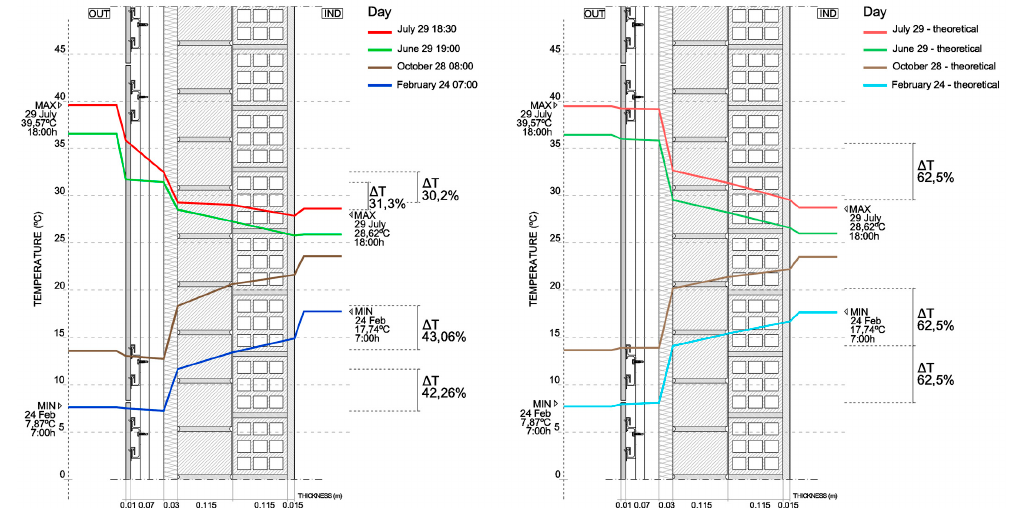
Figure 24. Comparison of temperature gradients in the insulation layer, and percentage of thermal gap T i − T o ( Left ) according to monitoring; ( Right ) according to the Fourier stationary regime. These data corresponding to actual thermal behaviour led to three possible hypotheses to explain these significant